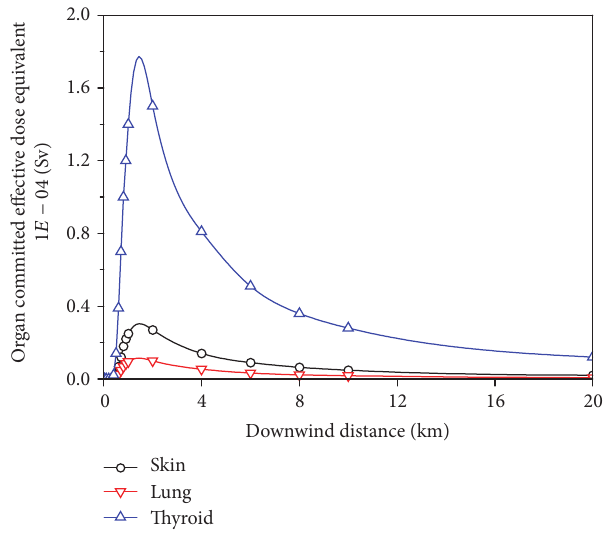
Figure 7: Target organ committed equivalent dose as a function of downwind